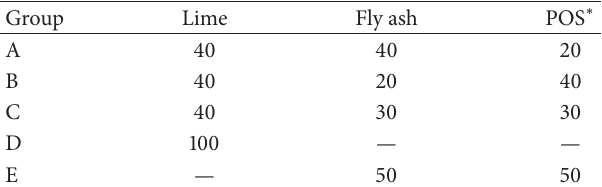
Table 1: Weight proportion of ingredients in cubic specimens.